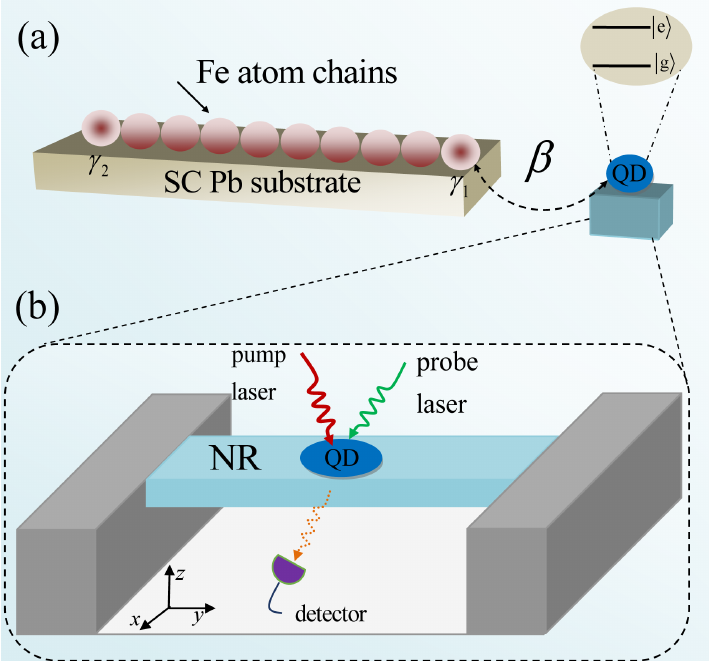
Figure 1. ( a ) The schematic of the hybrid device, where a two-level QD is coupled to a nearby MF in the iron chains on the superconducting Pb surface. ( b ) The QD driven by two-tone fields is embedded in an